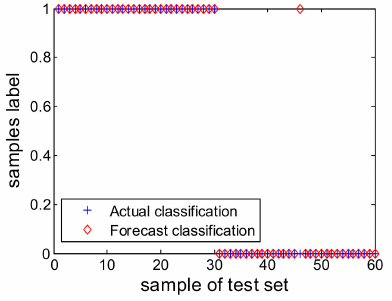
Figure 16. The accuracy of the classification model.